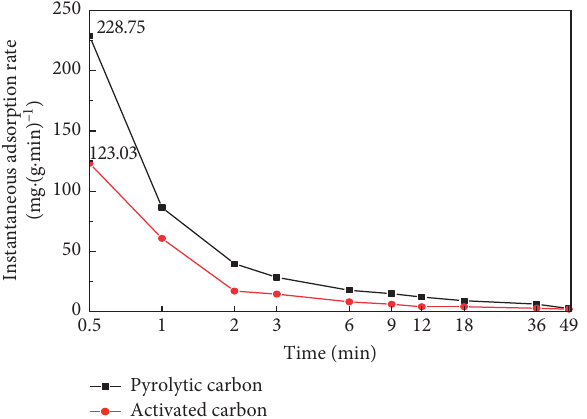
Figure 6: Comparison of instantaneous adsorption rate of pyrolytic carbon and activated carbon on crude